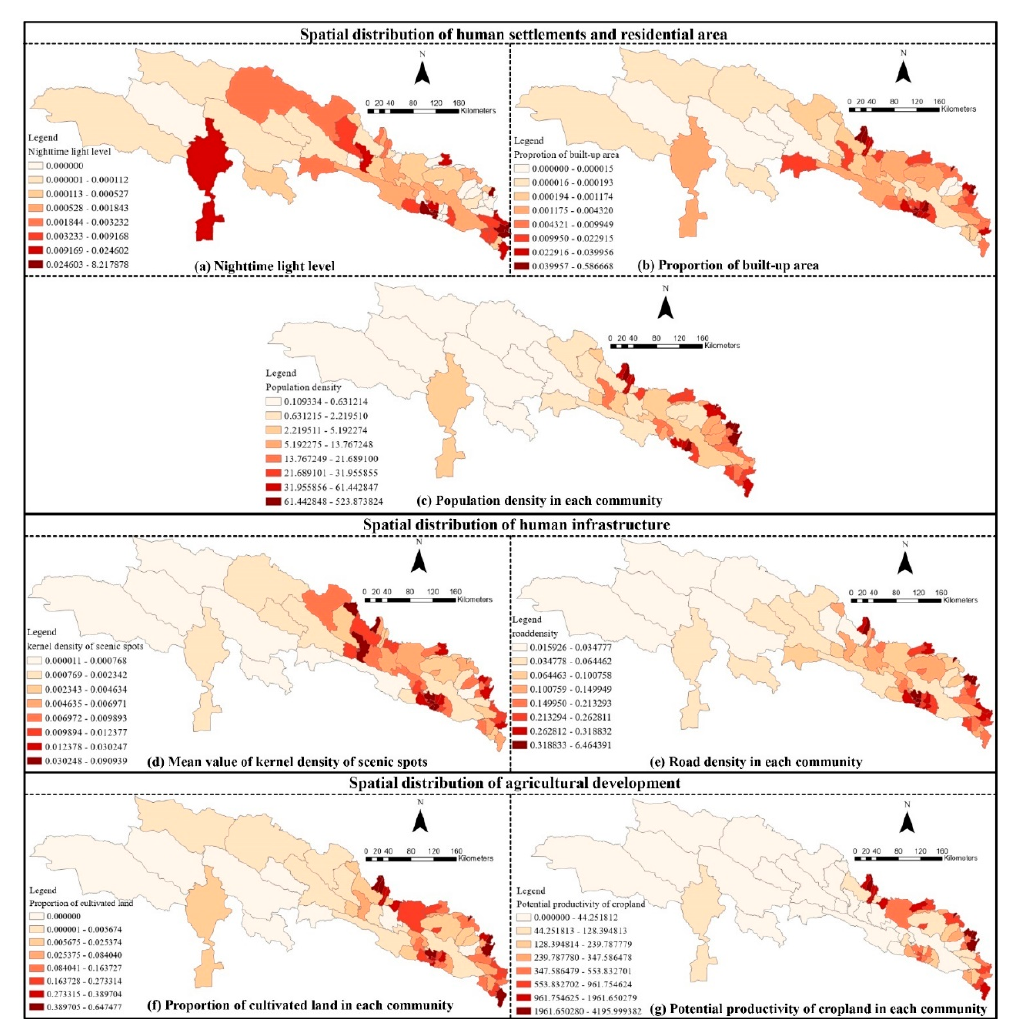
Figure 5. The spatial distributions of human settlements, infrastructure, and agricultural development in communities of QLMNP: ( a ) the nighttime light level; ( b ) the proportion of the built-up area; ( c ) the population density in each community; ( d ) the mean value of the kernel density of scenic spots; ( e ) the road density in each community; ( f ) the proportion of cultivated land in each community; ( g ) the potential productivity of cropland in each community.